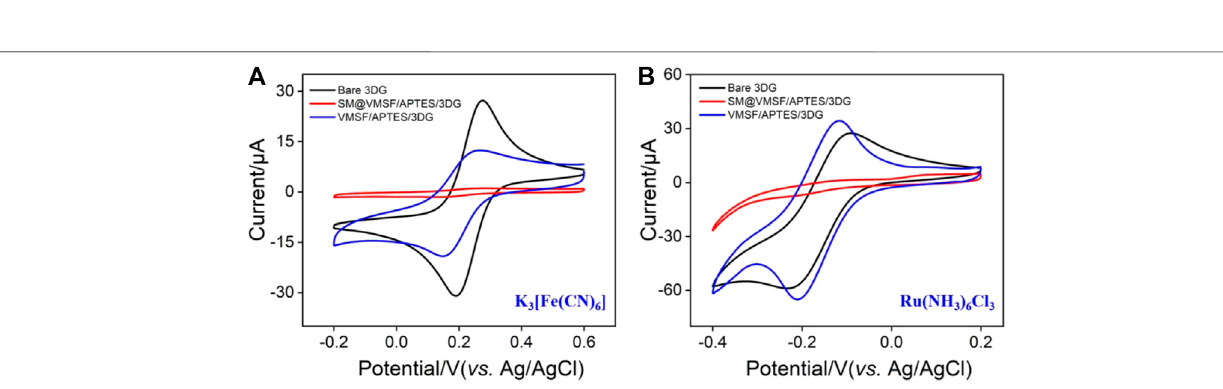
Frontiers in Chemistry |